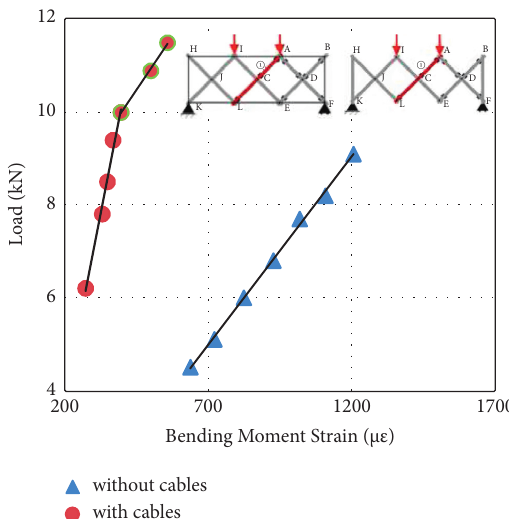
Figure 15: Load-bending strain comparison curves of structures with and without steel